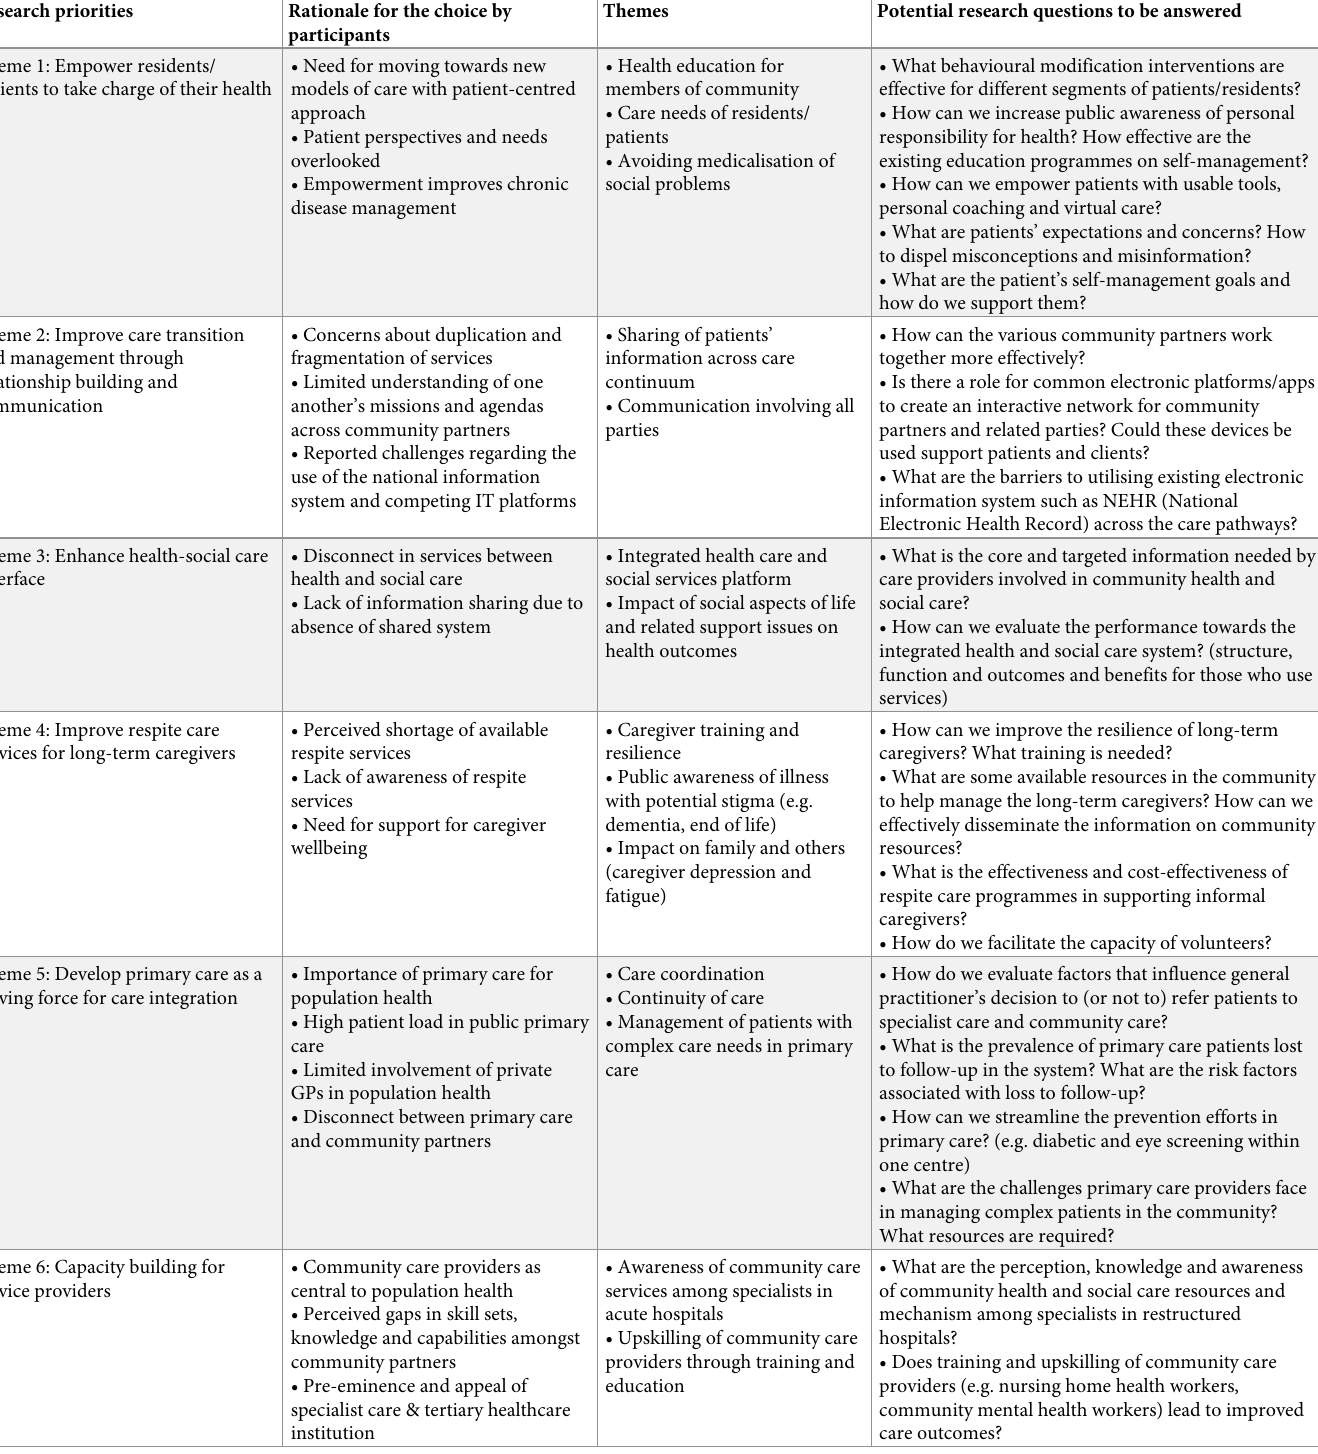
Table 5. Findings of phase 4—research priorities, themes and potential research